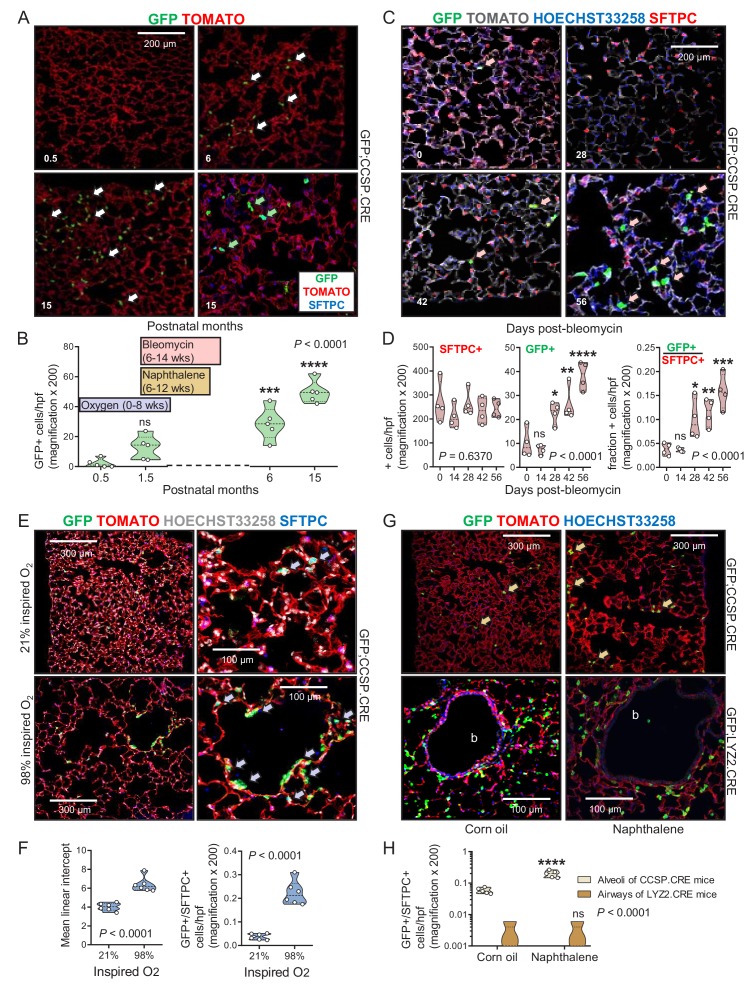
Airway cells in alveolar repair.(A) Non-neoplastic alveolar regions from lung sections of aging GFP;CCSP.CRE mice (bottom right section is also SFTPC-immunostained) show increasing numbers of alveolar GFP-labeled cells with age (arrows). Green arrows: genetically GFP-labeled, SFTPC-immunoreactive airway cells in alveolus of 15-month-old GFP;CCSP.CRE mouse. (B) Data summary (n = 5 mice/time-point) from (A) shown as violin plot. Color-coded boxes indicate time windows of experiments in (C-H). P, probability, one-way ANOVA. ns, ***, and ****: p>0.05, p<0.001, and p<0.0001, respectively, for comparison with time-point zero by Bonferroni post-tests. (C) SFTPC-immunostained lung sections of GFP;CCSP.CRE mice show accelerated increase of alveolar GFP-labeled SFTPC-immunoreactive airway cells after bleomycin treatment (arrows). See also Figure 4—figure supplement 1 and Figure 4—figure supplement 2. (D) Data summary from (C) shown as violin plots (n = 4 mice/time-point). P, probabilities, one-way ANOVA. ns, *, **, ***, and ****: p>0.05, p<0.05, p<0.01, p<0.001, and p<0.0001, respectively, for comparison with day zero by Bonferroni post-tests. (E) SFTPC-stained lung sections of GFP;CCSP.CRE mice at two months after perinatal exposure to 98% O2 show enlarged alveoli (evident by increased mean linear intercept) enriched in GFP-labeled SFTPC-immunoreactive airway cells (arrows) compared with 21% O2. (F) Data summary from (E) shown as violin plots (n = 6 mice/group). P, probabilities, t-test. (G) Lung sections (top) of GFP;CCSP.CRE mice (n = 5 mice/group) show enrichment of alveoli in GFP-labeled cells post-naphthalene treatment (arrows). Lung sections (bottom) of GFP;LYZ2.CRE mice (n = 5 mice/group) at six weeks post-naphthalene show no bronchial (b) GFP-labeled cells. See also Figure 4—figure supplements 3 and 4. (H) Data summary from (G) shown as violin plot (n = 5 mice/time-point). P, probability, two-way ANOVA. ns and ****: p>0.05 and p<0.0001, respectively, for comparison with corn oil by Bonferroni post-tests. CCSP, Clara cell secretory protein; SFTPC, surfactant protein C; LYZ2, lysozyme 2.10.7554/eLife.45571.047Figure 4—source data 1.Quantification of alveolar GFP+ cells in GFP;CCSP.CRE mice during aging.10.7554/eLife.45571.048Figure 4—source data 2.Quantification of SFTPC+ and GFP+ cells in GFP;CCSP.CRE mice after bleomycin treatment.10.7554/eLife.45571.049Figure 4—source data 3.Data of mean linear intercept and GFP+/SFTPC+cells in GFP;CCSP.CRE mice after hyperoxia treatment.10.7554/eLife.45571.050Figure 4—source data 4.Data of GFP+/SFTPC+ cells in GFP;CCSP.CRE and GFP;LYZ2.CRE mice after naphthalene treatment.